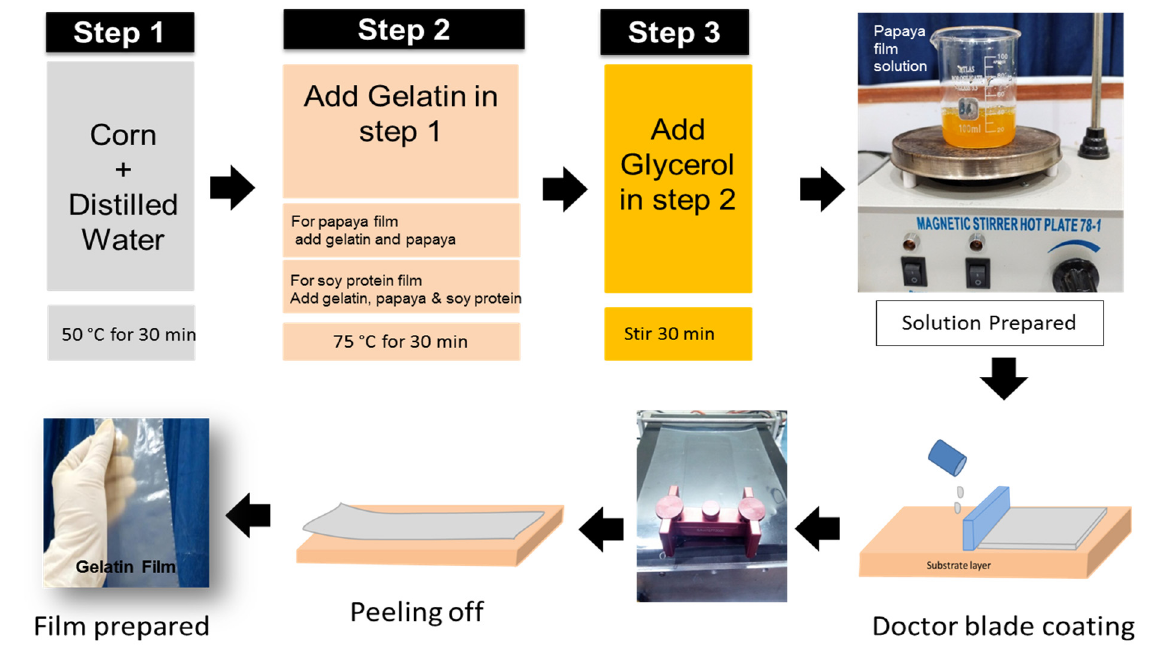
Figure 1. Schematic diagrams of the process flow for the preparation of solution and processing of edible films. Table 1. Composition of samples along with the sample identification acronyms. Sample Composition